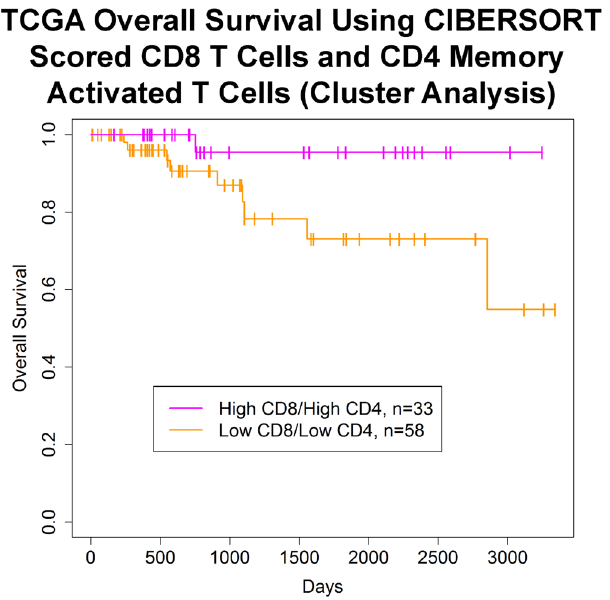
Figure 7. Kaplan–Meier curve demonstrating improvements in OS in TCGA TNBC patients with high quantities of CD8 T cells and CD4 memory activated T cells in their tumor sample. TCGA TNBC patients with a higher amount of CD8 T cells and CD4 memory activated T cells in their tumor as compared to samples with a lower amount of both these cell types have a better OS (p = 0.037, FDR = 0.11, log rank test) (survival rates high vs. low, 5 year: 95.5% and 73.1%, 10 year: 95.5% and 54.8%). The high and low groups were identified according to the hierarchical clustering analysis in Fig. 5. Image generated with R 4.0.2 (https ://www.R-proje ct.org) 35